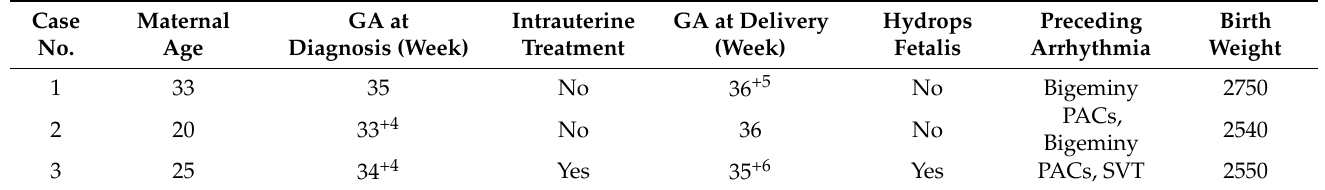
Table 1. Characteristics of the three cases with atrial flutter associated with septal